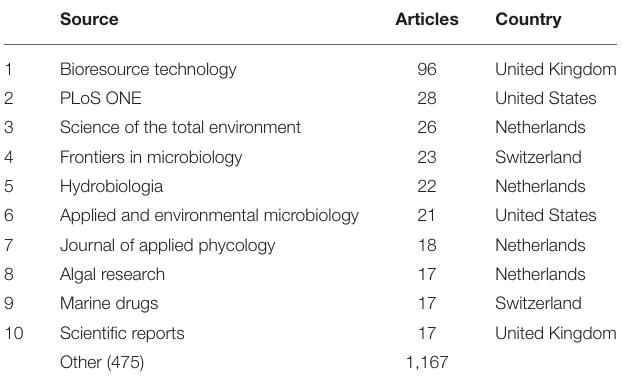
TABLE 2 | The 10 most-productive journals in microalgae-fungi